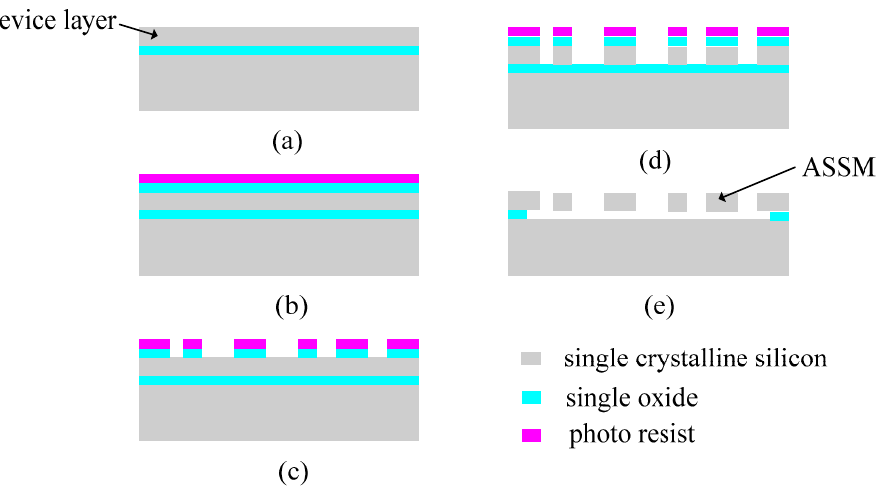
Figure A1. Fabrication processes. ( a ) Cleaning of an SOI wafer, ( b ) depositing silicon oxide layer by